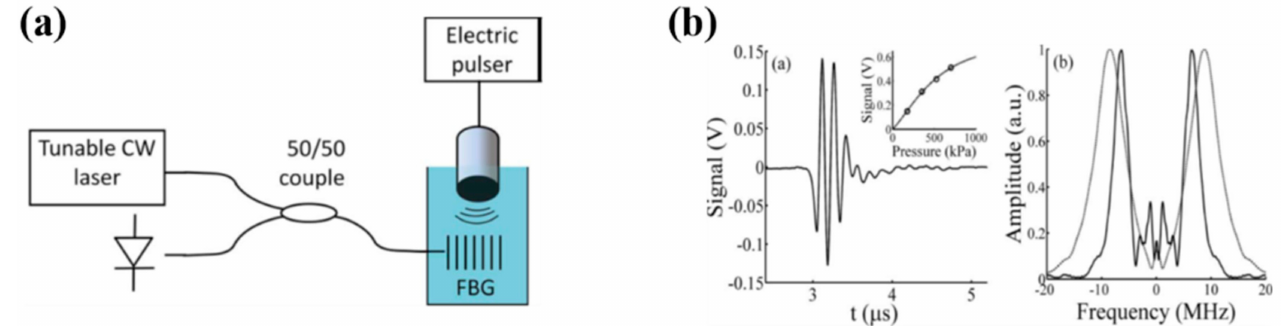
Figure 14. ( a ) Schematic description of the ultrasonic field measurement. ( b ) Temporal and spec- tral responses of the optical sensor obtained for an acoustic plane wave formed by an ultrasound transducer. Adapted with permission from ref. [96]. © The Optical Society.